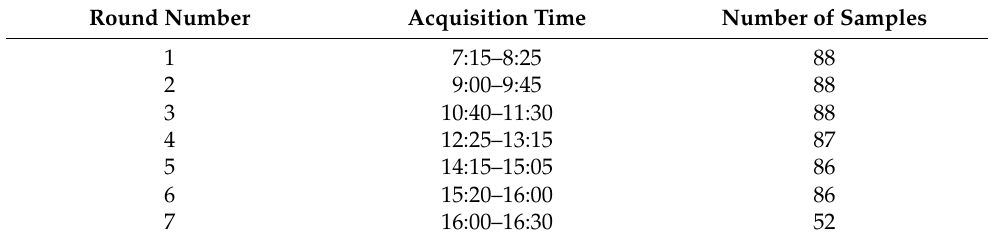
Table 2. Diurnal acquisition: Time of image acquisition and number of